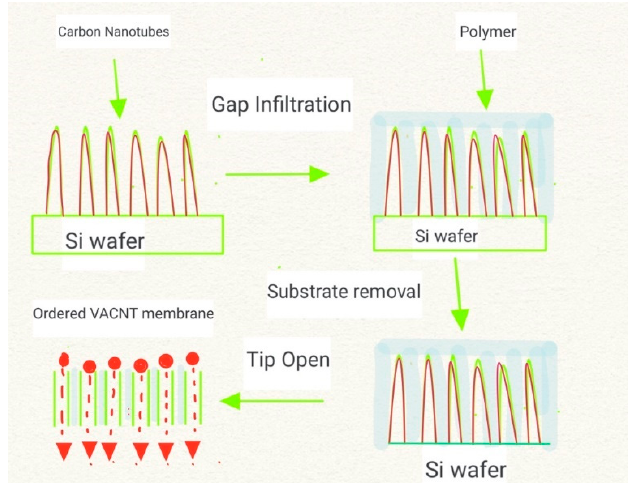
Figure 1. Synthesis process of VA-CNT.CVD is initially employed for the synthesis of VA-CNTs on a silicon (Si) wafer pre-coated with metal catalytic particles. Subsequently, gap infiltration takes place with polymers (e.g., epoxy or polystyrene) under vacuum. The substrate is then removed by etching, and finally, a tip opening is carried out by mechanical polishing, ion etching, or plasma etching [25].